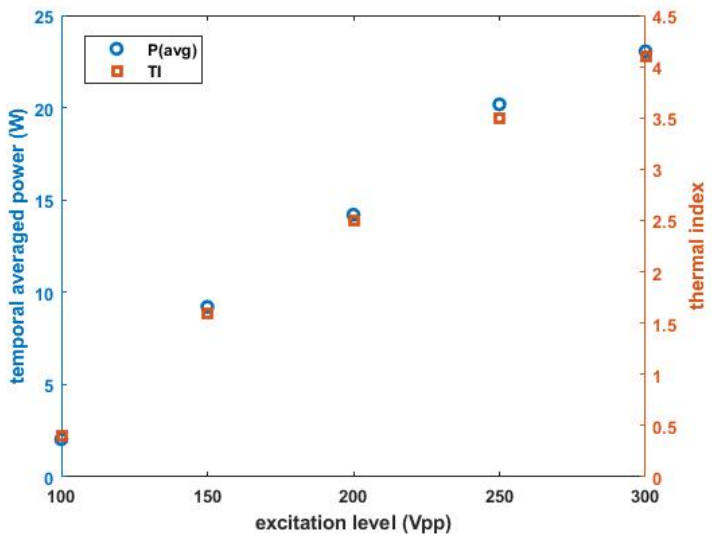
Figure 12. Temporal average power output of the transducer as a function of excitation voltage.